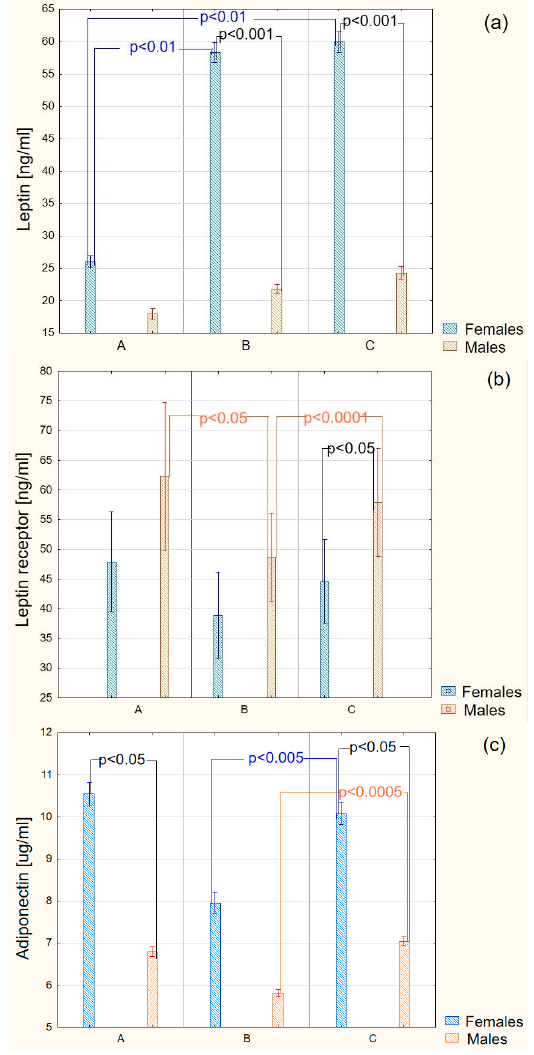
Figure 1. Differences in the concentration of plasma leptin ( a ), plasma leptin receptor ( b ), and plasma adiponectin ( c ) between healthy subjects ( A ) ( n = 27), diabetic patients before treatment ( B ) ( n = 40), and diabetic patients after a six-month therapy ( C ) ( n = 40), depending on the gender.